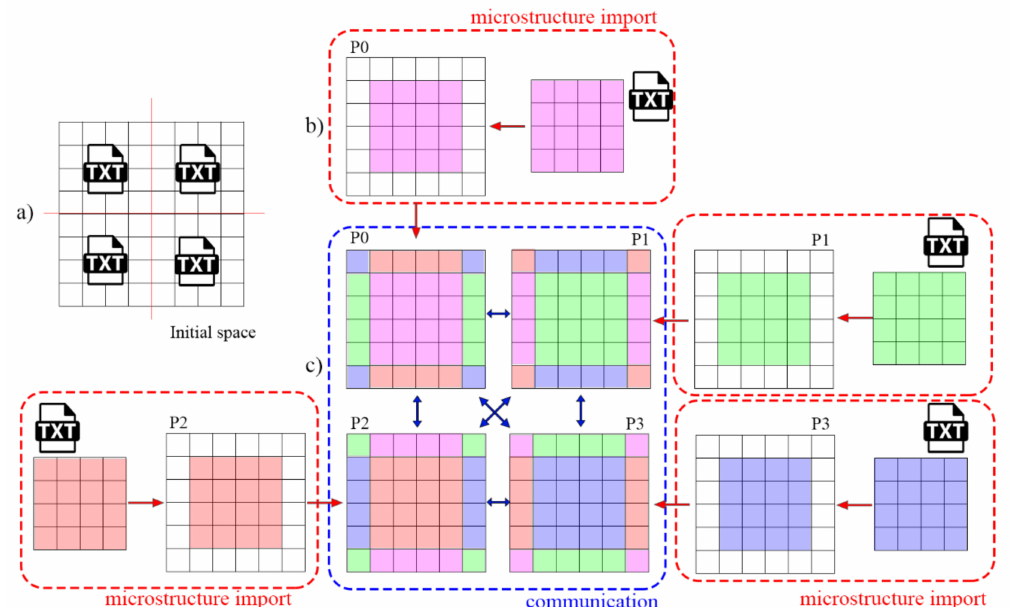
Figure 4. CA space preparation steps for the second parallelization scheme (mode 2). ( a ) the entire CA computational domain, ( b ) initial microstructure data loaded to each MPI process from dedicated files, and ( c ) information exchange within the boundary buffer zones for all neighboring MPI